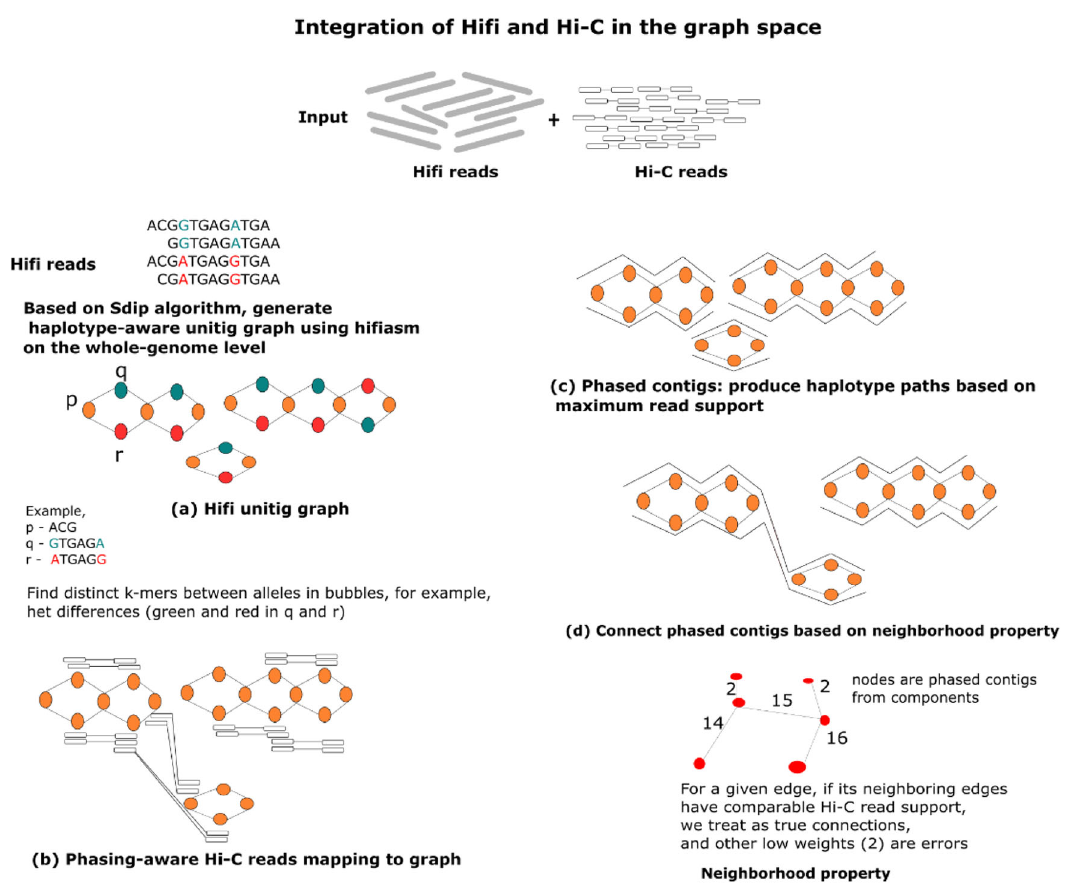
Fig. 2 | Overview of the pstools algorithm. a Produce a HiFi sequence graph that retainsbubblesandanycomplexevents, b MaptheHi-Creadstonodesequencesin the sequence graph, c Phase the bubble chains in the graph to produce haplotype